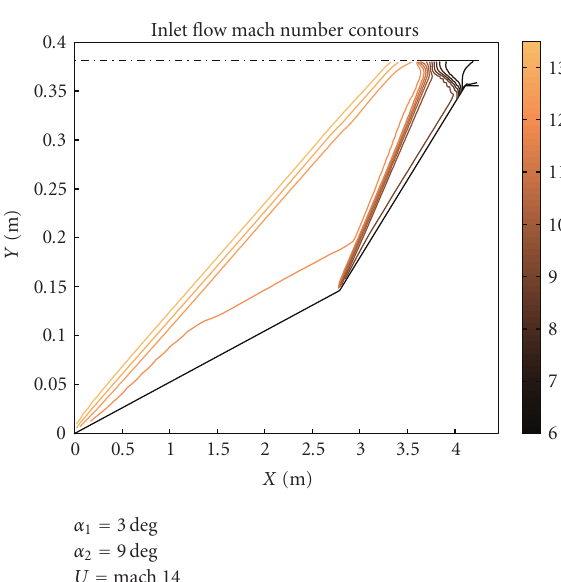
Figure 7: Mach contours for o ff nominal cowl inlet.